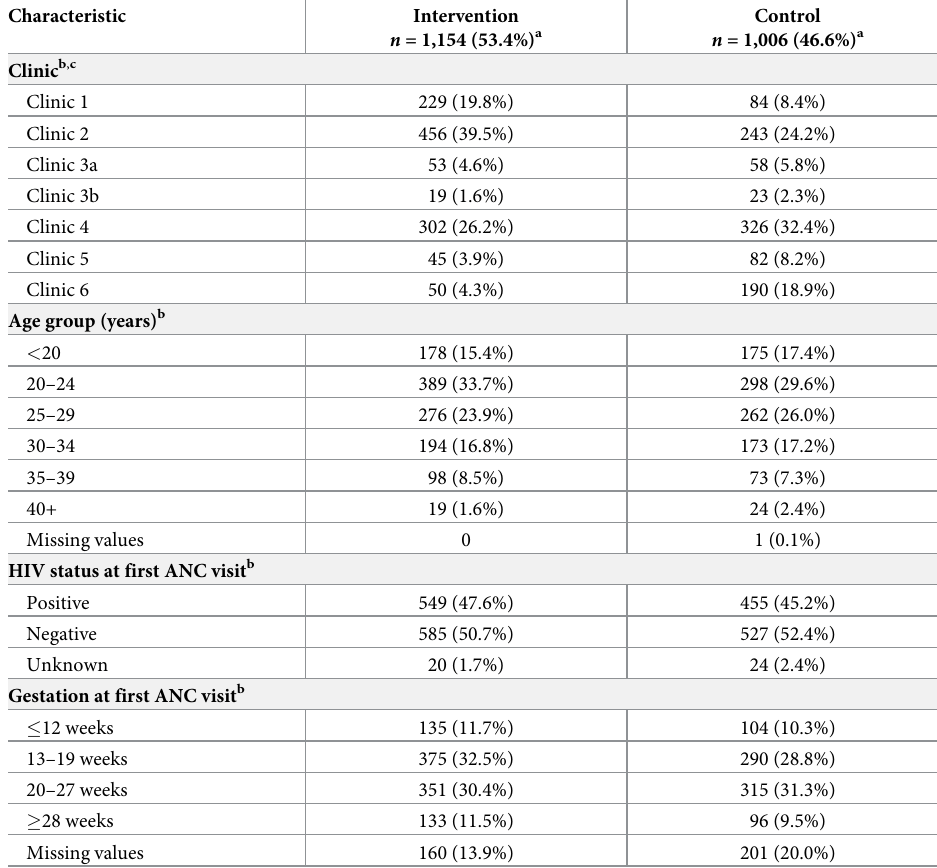
Table 2. Summary of participant characteristics by CQI intervention exposure